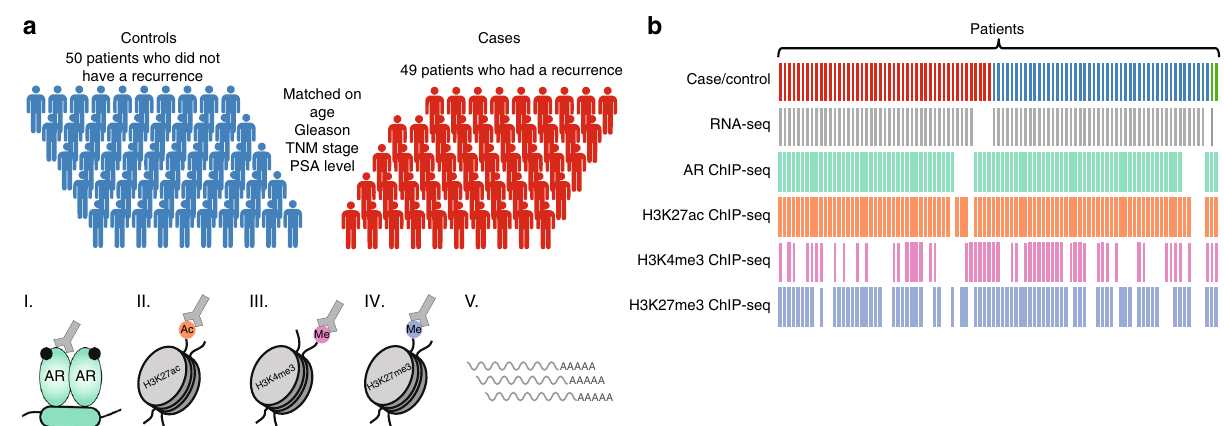
(Fig. 3a, b), which was con fi rmed in principal component analysis (Supplementary Figure 7). RNA-seq clusters 1 and 2 (dark blue and light green clusters) were relatively enriched for high Gleason score ( p -value = 0.005), while no differences in Gleason score were observed for all ChIP-seq based clusters. Samples were further classi fi ed into luminal and basal-like subtype using the PAM50 classi fi er, which was recently applied successfully in prostate cancer 14 (Supplementary Figure 8). Notably, RNA-seq clusters 1 and 2 (dark blue and light green clusters) were mainly comprised of luminal B tumors, while clusters 4 and 5 (light blue and dark green clusters) contained the majority of samples clas- si fi ed as luminal A ( p- value = 6.83e − 06). However, the PAM50 subtypes distributed almost evenly between all clusters in the ChIP-seq datasets. Next, we analyzed AR pathway activation within the tumors using a previously reported AR activity sig- nature 24 , which was also implemented in the TCGA report on